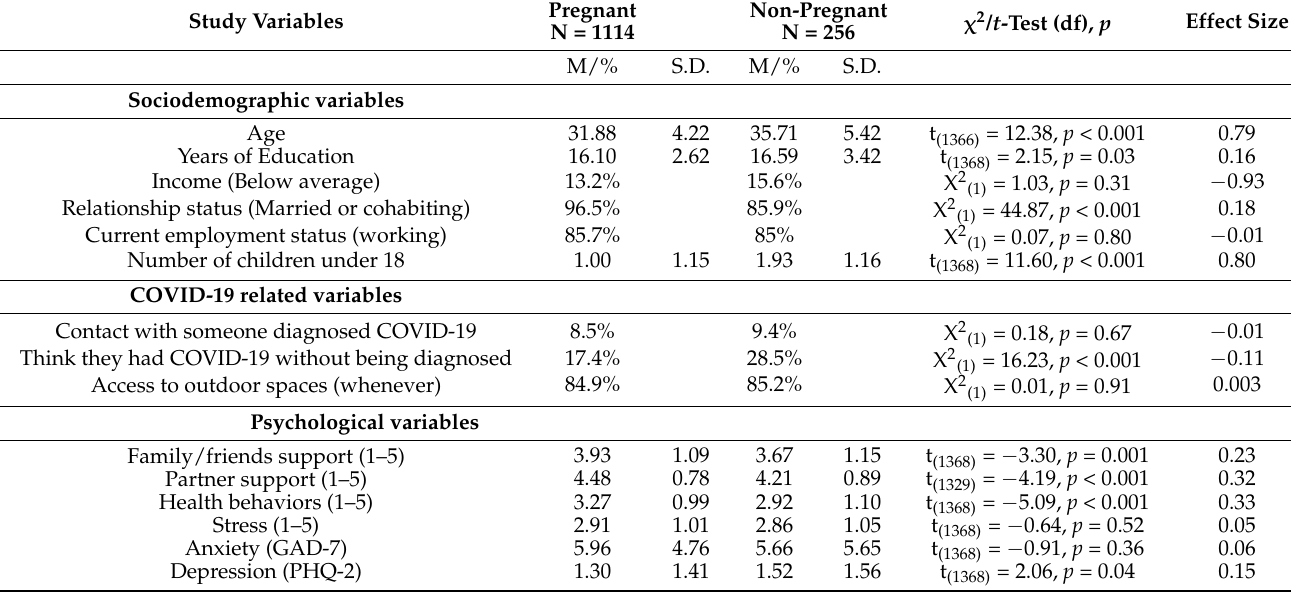
Figure 1. Mental health resiliency in pregnant women. ( a ) Pregnant women show fewer depressive symptoms than non- pregnant women. Depression symptoms were measured using the Patient Health Questionnaire-2 (PHQ-2), which inquires about the frequency of depressed mood and anhedonia over the past two weeks. ( b ) Pregnant women are less concerned that they have COVID-19, even without being diagnosed, compared to non-pregnant women. Note: PHQ-2 = Patient Health Questionnaire-2. * p < 0.05, *** p < 0.001. Table 1. Means and standard errors for main study factors among pregnant and non-pregnant women.